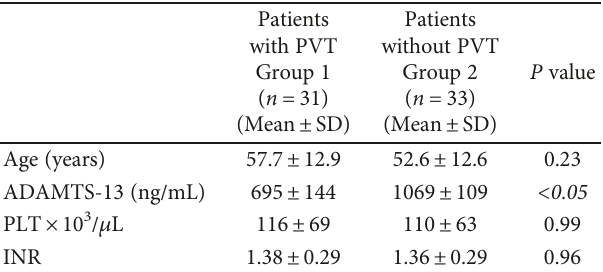
Table 2: Comparison of the analyzed markers in group 1 (with PVT) and group 2 (without PVT).